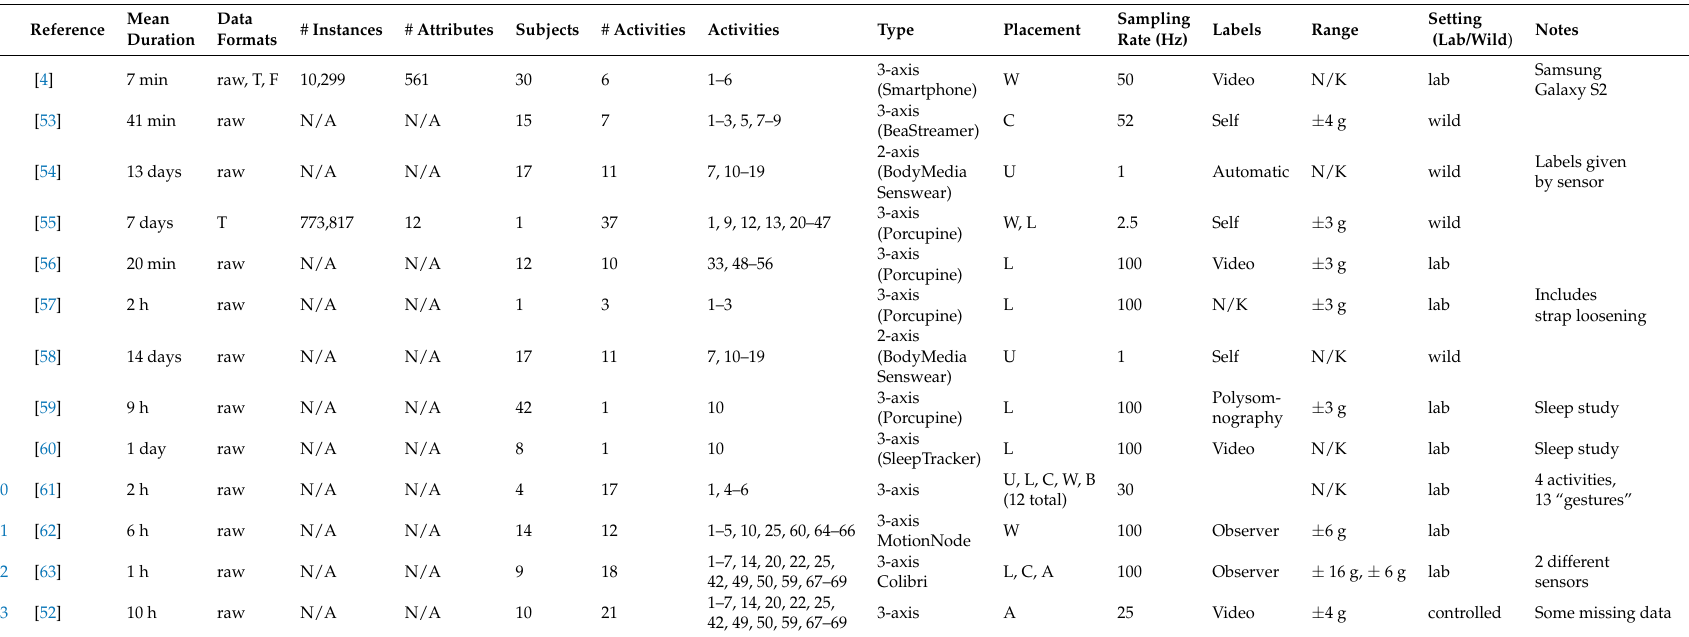
Table 2. Publicly available data-sets for activity recognition based on body-worn accelerometers. For activities see Table 1. Data formats: T = Time domain, F